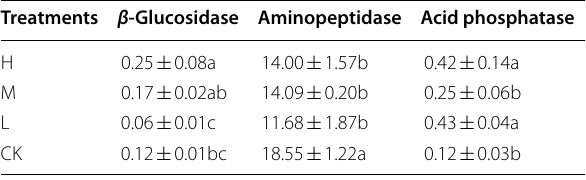
Table 1 Soil enzyme activities under four different N application